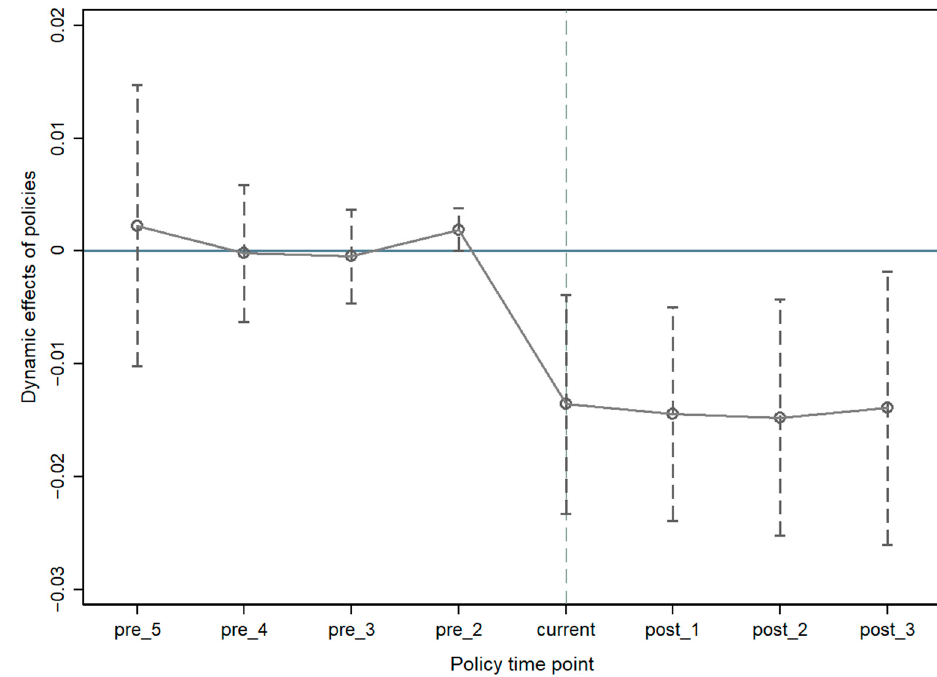
Figure 6. Parallel Trend Charts.